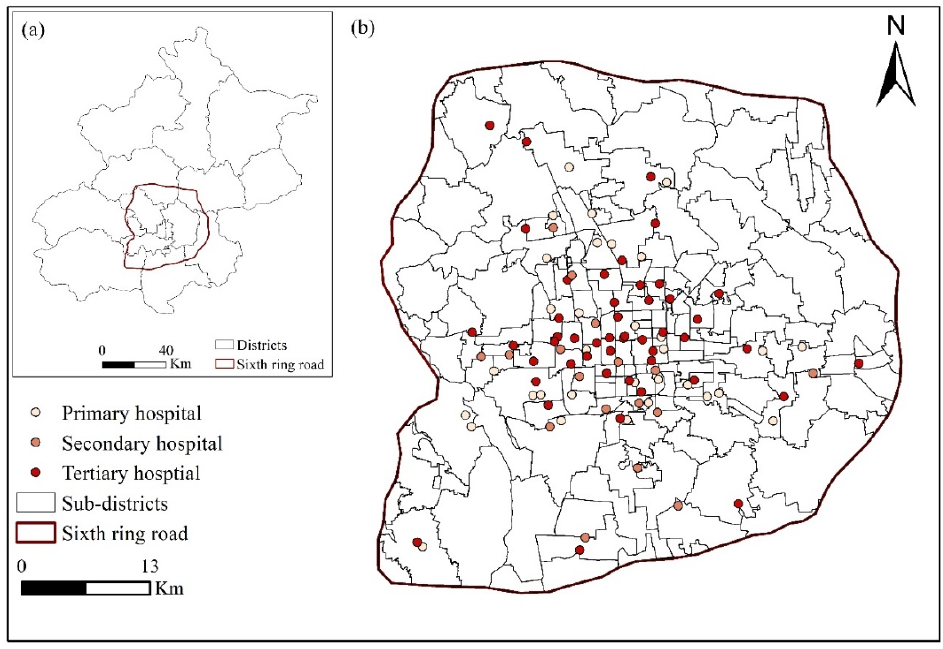
Figure 1. ( a ) Study area within the sixth ring road of Beijing; ( b ) primary, secondary, and tertiary public general hospitals, and subdistricts as basic statistical units.